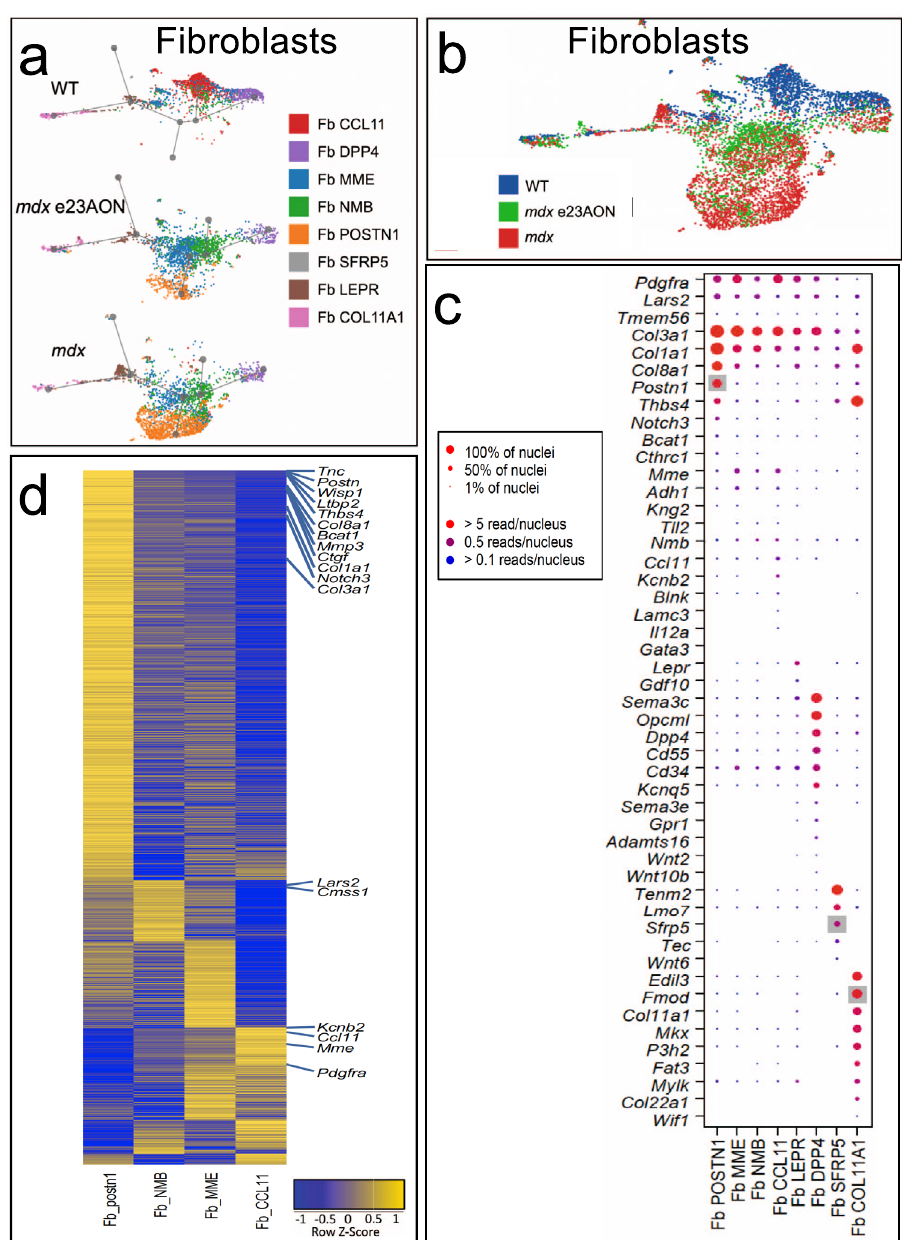
Fig. 5 In fl ammatory fi broblast populations dominate within dystrophic muscle while exon-skipping drug-treated muscle shows reduction of these populations and a transcriptomic return toward WT fi broblast patterns of gene expression. a U-map pseudotime analysis and lineage tracing of fi broblast subset types was performed for WT ( n = 3), mdx e23AON ( n = 4), and mdx ( n = 4), with each fi broblast type labeled as a color and a prominent gene that is highly expressed as indicated. b All Fibroblast subtypes are arranged according to their transcriptional relatedness with each nucleus labeled by mouse sources as indicated. c Gene expression for descriptive genes characterizing fi broblast cell subset populations shown in a . Gray background indicates known markers of the respective cell type on x -axis. (Complete list of signi fi cantly different genes is found in Supplementary Data 2). Dot size indicates percent of nuclei expressing the gene of interest, dot color indicates level of expression. d Heatmap of gene expression differences between Fb CCL11 and Fb POSTN1 were generated for and these genes heatmaps shown for Fb NMB and Fb MME to demonstrate a transitional expression pattern in these cells between Fb POSTN1 and Fb population not detected in our dataset of 11,485 total nuclei 10.6% of all nuclei, Fig. 2, Supplementary Fig. 18c). Based on from WT muscle, was expanded to 8.8% of all nuclei in mdx pseudo-lineage tracing and gene expression (Supplementary muscle (37.7% of all mdx fi broblasts) ( p = 0.017) as were Fb Data 2), we infer that fi broblasts that are expanded in mdx NMB (4.5% of all nuclei mdx vs 0.9% WT) and Fb MME (5.7% represent trans -differentiation from WT muscle resident fi broblasts (Fb CCL11 and Fb DPP4) which are not of all nuclei mdx vs 2.1% WT). Fibroblast populations shifted with induction of dystrophin by e23AON exon skipping: There proin fl ammatory to relatively more proin fl ammatory/pro fi bro- was a contraction of Fb POSTN1 (8.8% of all nuclei mdx vs tic fi broblasts, particularly Fb POSTN1 (Figs. 2, 5a, Supple- 3.0% mdx e23AON), and near doubling of Fb MME (5.7% vs. mentary Data 3b) 37 – 39 .